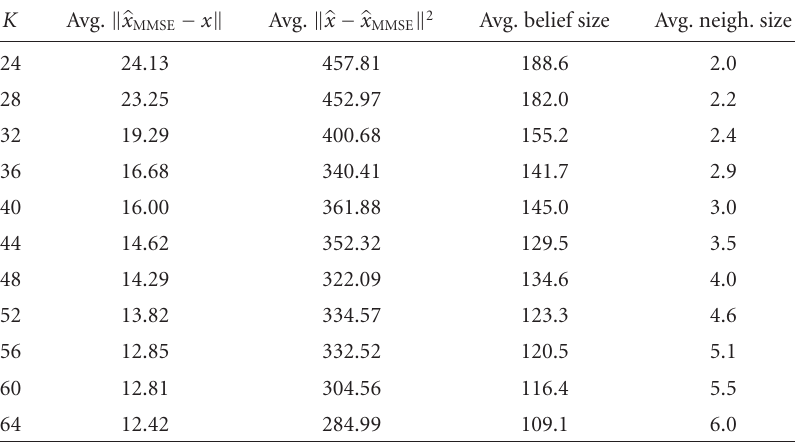
Table 3: Tracking performance averaged over all tracking steps and twenty runs.